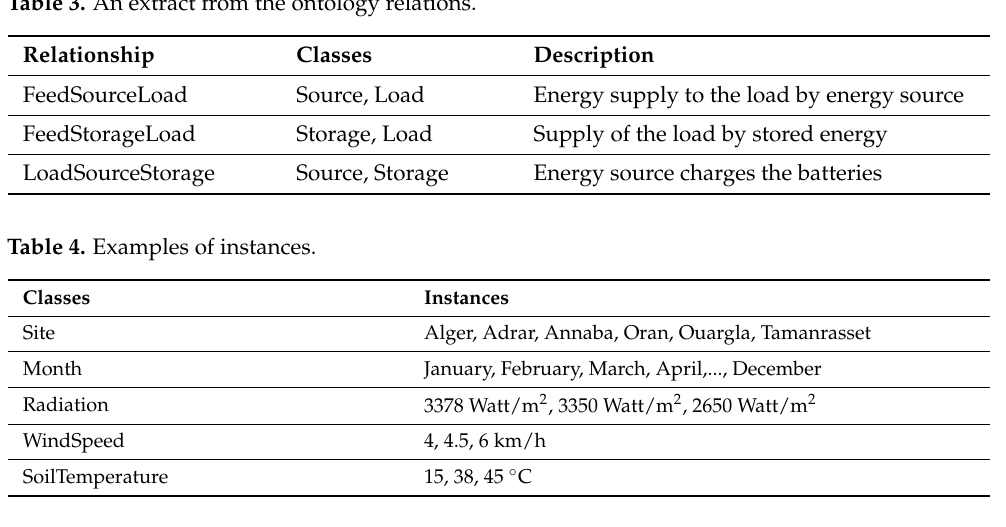
Table 3. An extract from the ontology relations.